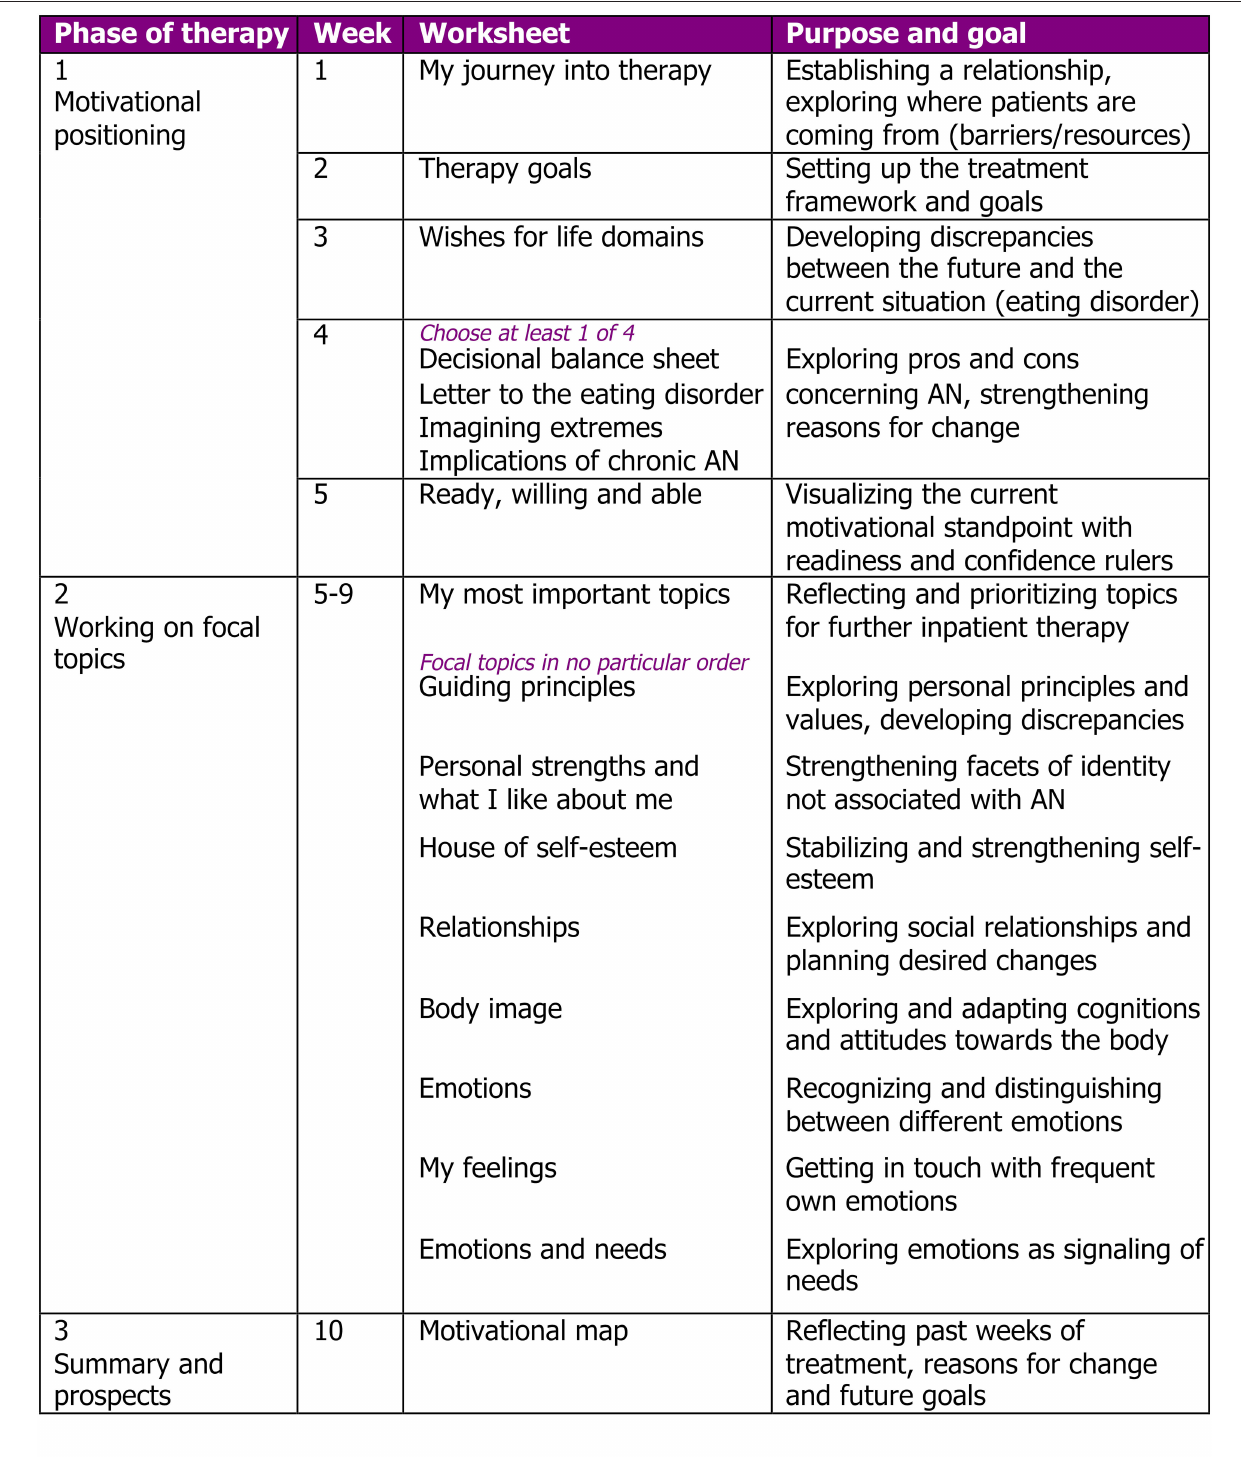
FIGURE 1 | Overview of the MANNA